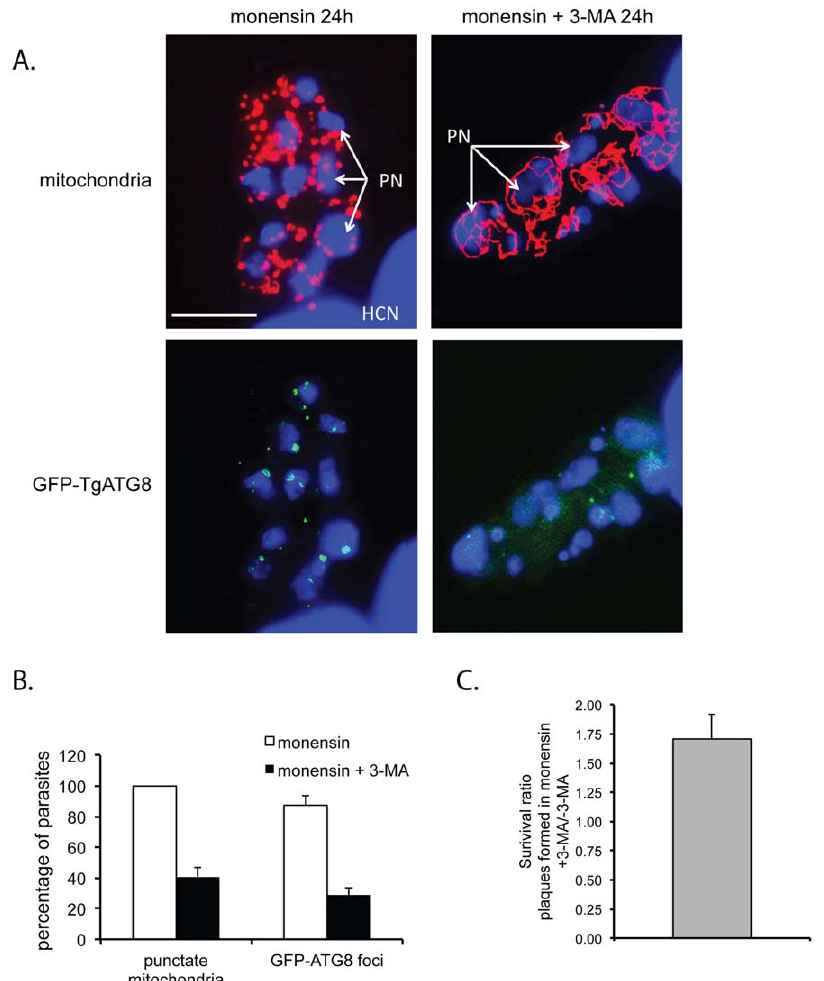
Figure 6. The autophagy inhibitor 3-methyladenine (3-MA) blocks autophagy and mitochondrial alteration induced by monensin. (A) Deconvolved fluorescence micrographs of intracellular T. gondii exposed to 0.75 ng/ml monensin or 0.75 ng/ml monensin plus 10 mM 3-MA for 24 hours. Red=mitochondria, green=GFP-ATG8, blue=DNA. PN, parasite nuclei; HCN, host cell nuclei. (B) Quantification of number of parasites positive for punctate mitochondria or GFP-ATG8 autophagosome foci after exposure to 0.75 ng/ml monensin for 24 hours (white bars) or 0.75 ng/ml monensin + 10 mM 3-MA for 24 hours (black bars). Each bar represents the mean value for three independent replicates. Error bar equals the standard deviation. Scale bar=10 m m. (C) The bar represents the ratio of number of plaques formed in 0.75 ng/ml monensin + 10 mM 3-MA over that in only 0.75 ng/ml monensin. Error bar is the standard deviation.